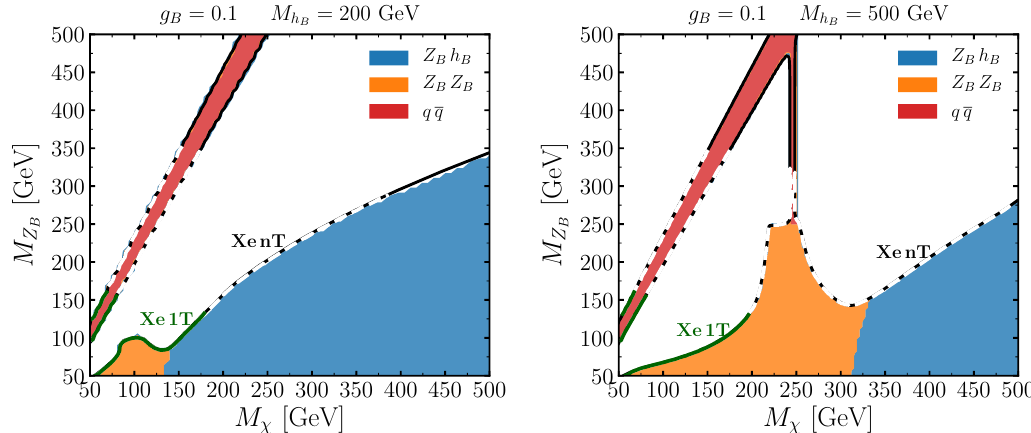
plane. In the left Figure 2 . Contour plot for the dark matter relic density in the M χ versus M Z B (right) panel the mass of the second Higgs has been fixed to M = 200 GeV (500 GeV). The solid h B black line gives the measured relic abundance by the Planck satellite Ω 2 = 0 . 1200 ± 0 . 0012 [19]. χ h The colored region satisfies the constraint Ω 2 ≤ 0 . 12 and the different colors correspond to χ h different dominant annihilation channels as indiciated in the legend. The solid green line shows the region ruled out by Xenon-1T [20], the dashed black line shows the projected sensitivity for Xenon-nT [21], both for zero mixing angle. For small mixing angles, the dark matter relic density and the direct detection are almost independent of the scalar mixing angle as explained in the text.